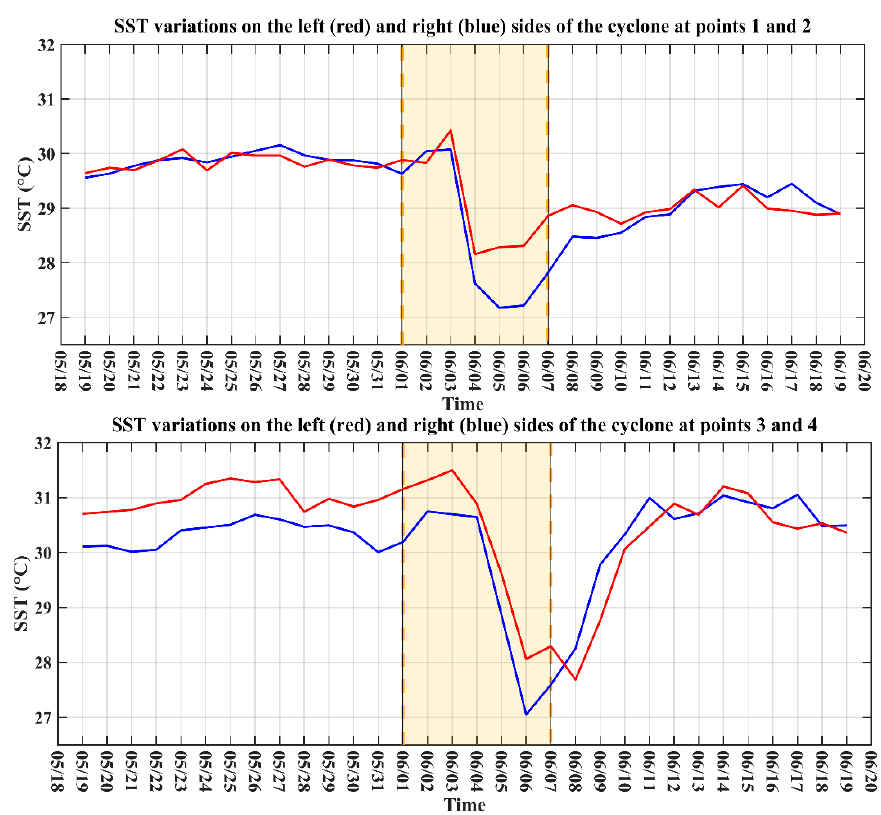
Figure 5. 31-day SST variations at the two pairs of points located on the right (blue line) and left (red line) of Gonu’s track. The shaded zone shows the active period of Gonu in the study region.